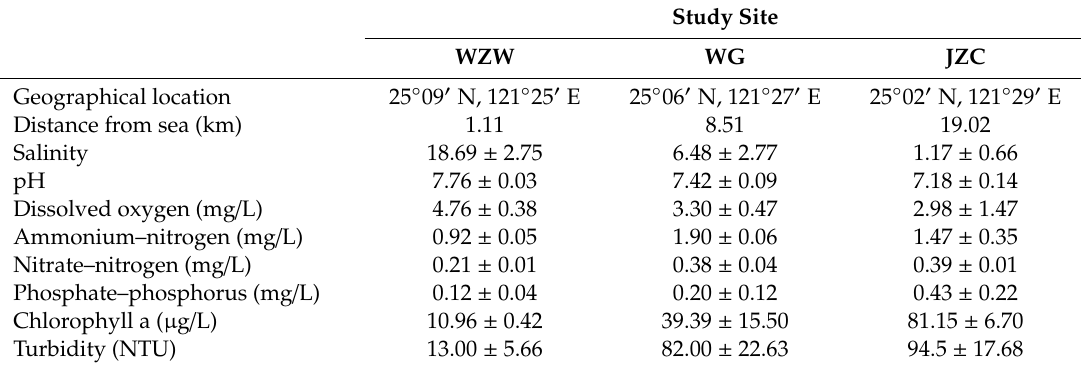
Table 1. Physio-chemical parameters (mean ± SD) of the studied Danshuei Riverine Mangrove measured during the study